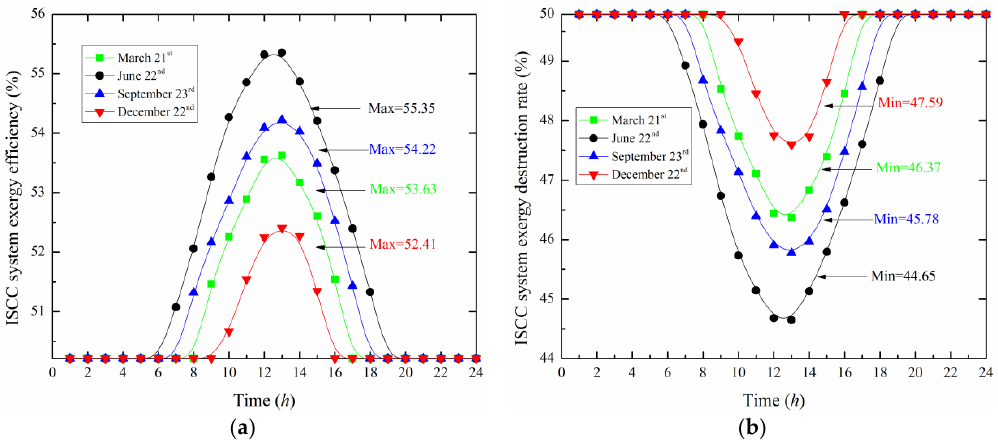
Figure 3. The performance of overall system variation with time. ( a ) The efficiency of ISCC system exergy variation with time. ( b ) The overall system exergy destruction rate variation with time.